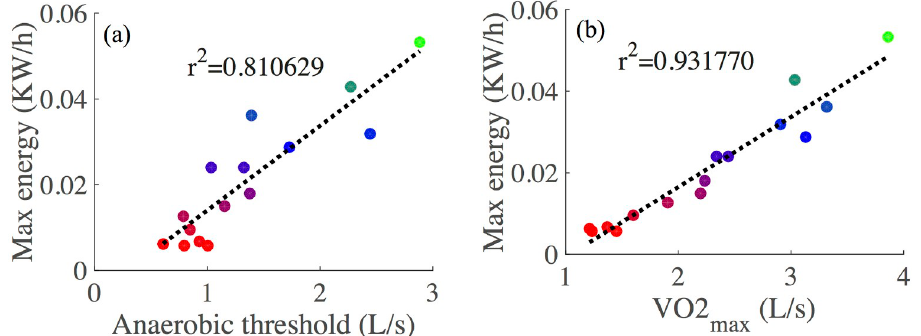
Fig 9. (a) Quantifying the relationship between the anaerobic threshold and overall test performance. Thresholds were calculated using an automated procedure based on previous methods [46] (b) _ VO overall test performance.